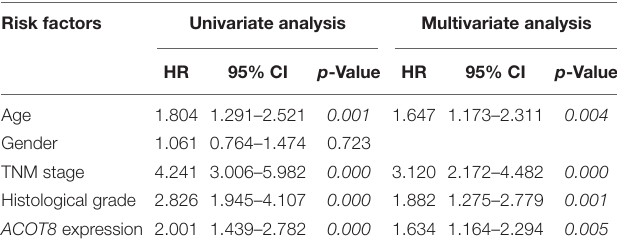
TABLE 2 | Univariate and multivariate Cox regression analyses of overall survival in ccRCC patients. Risk